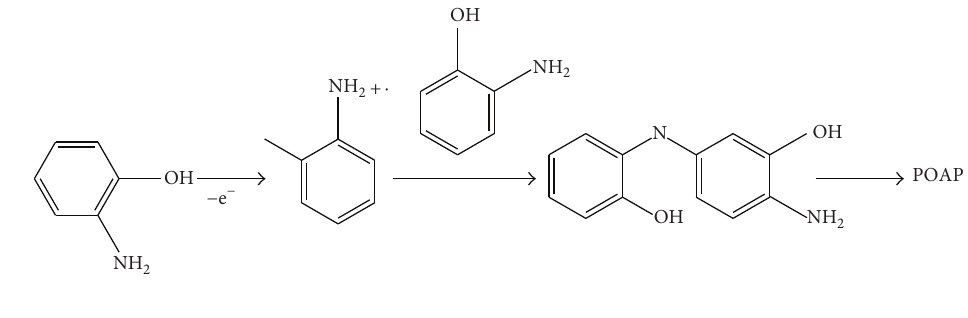
F 6: Scheme of o -AP oxidation to produce POAP [49].